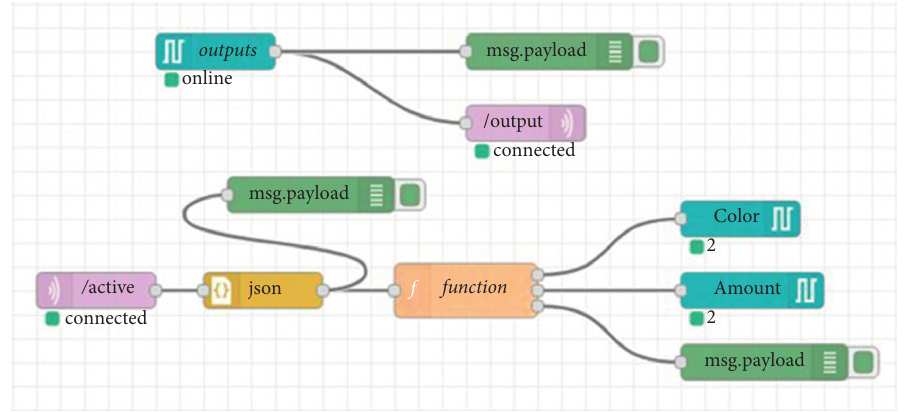
Figure 7: Block diagram of the cloud communication support